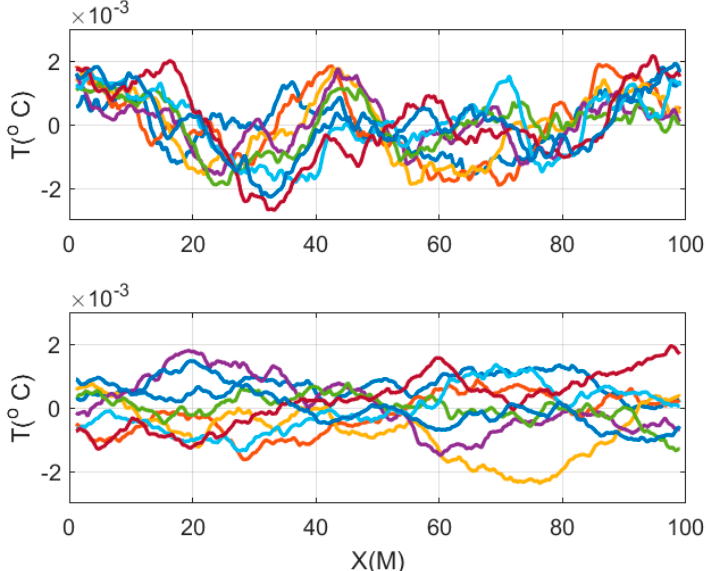
Figure 3. Representative temperature fluctuations for characteristic spatial variation in Fennoscandia basement rock thermal conductivity. Computation based on Hm scale thermal conductivity sequences from 2.5 km wellbore [28].